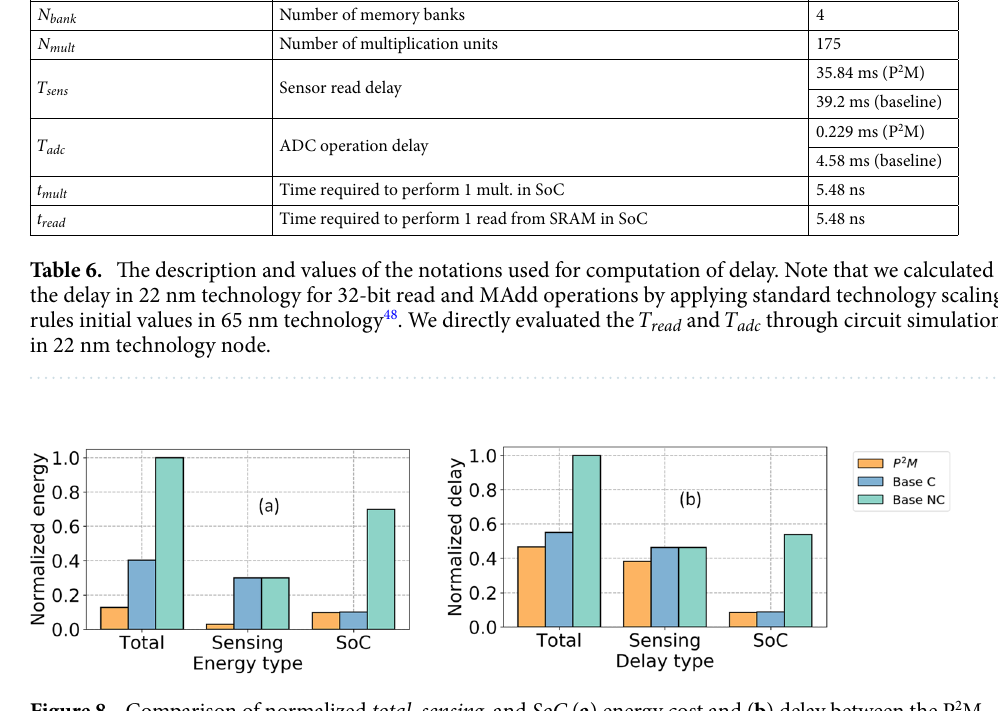
Figure 8. Comparison of normalized total , sensing , and SoC ( a ) energy cost and ( b ) delay between the P 2 M, and baseline models architectures (compressed C, and non-compressed NC). Note, the normalization of each component was done by diving the corresponding energy (delay) value with the maximum total energy (delay) value of the three